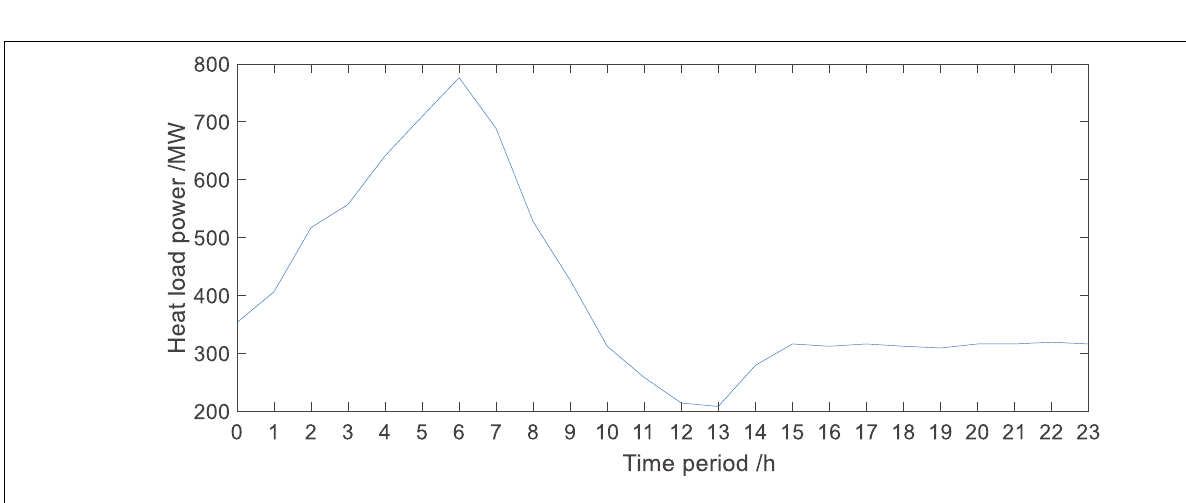
FIGURE 10 | Heat load curve.